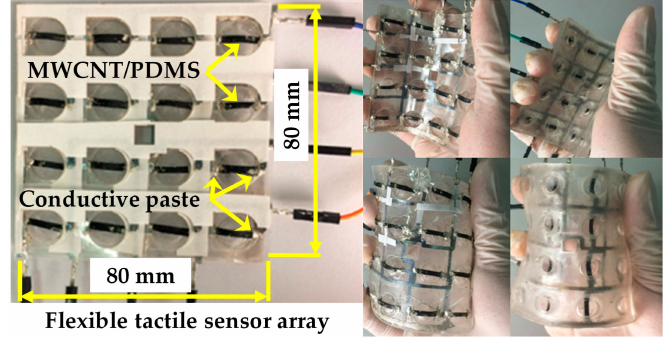
Figure 4. Photograph of the integrated flexible tactile sensor